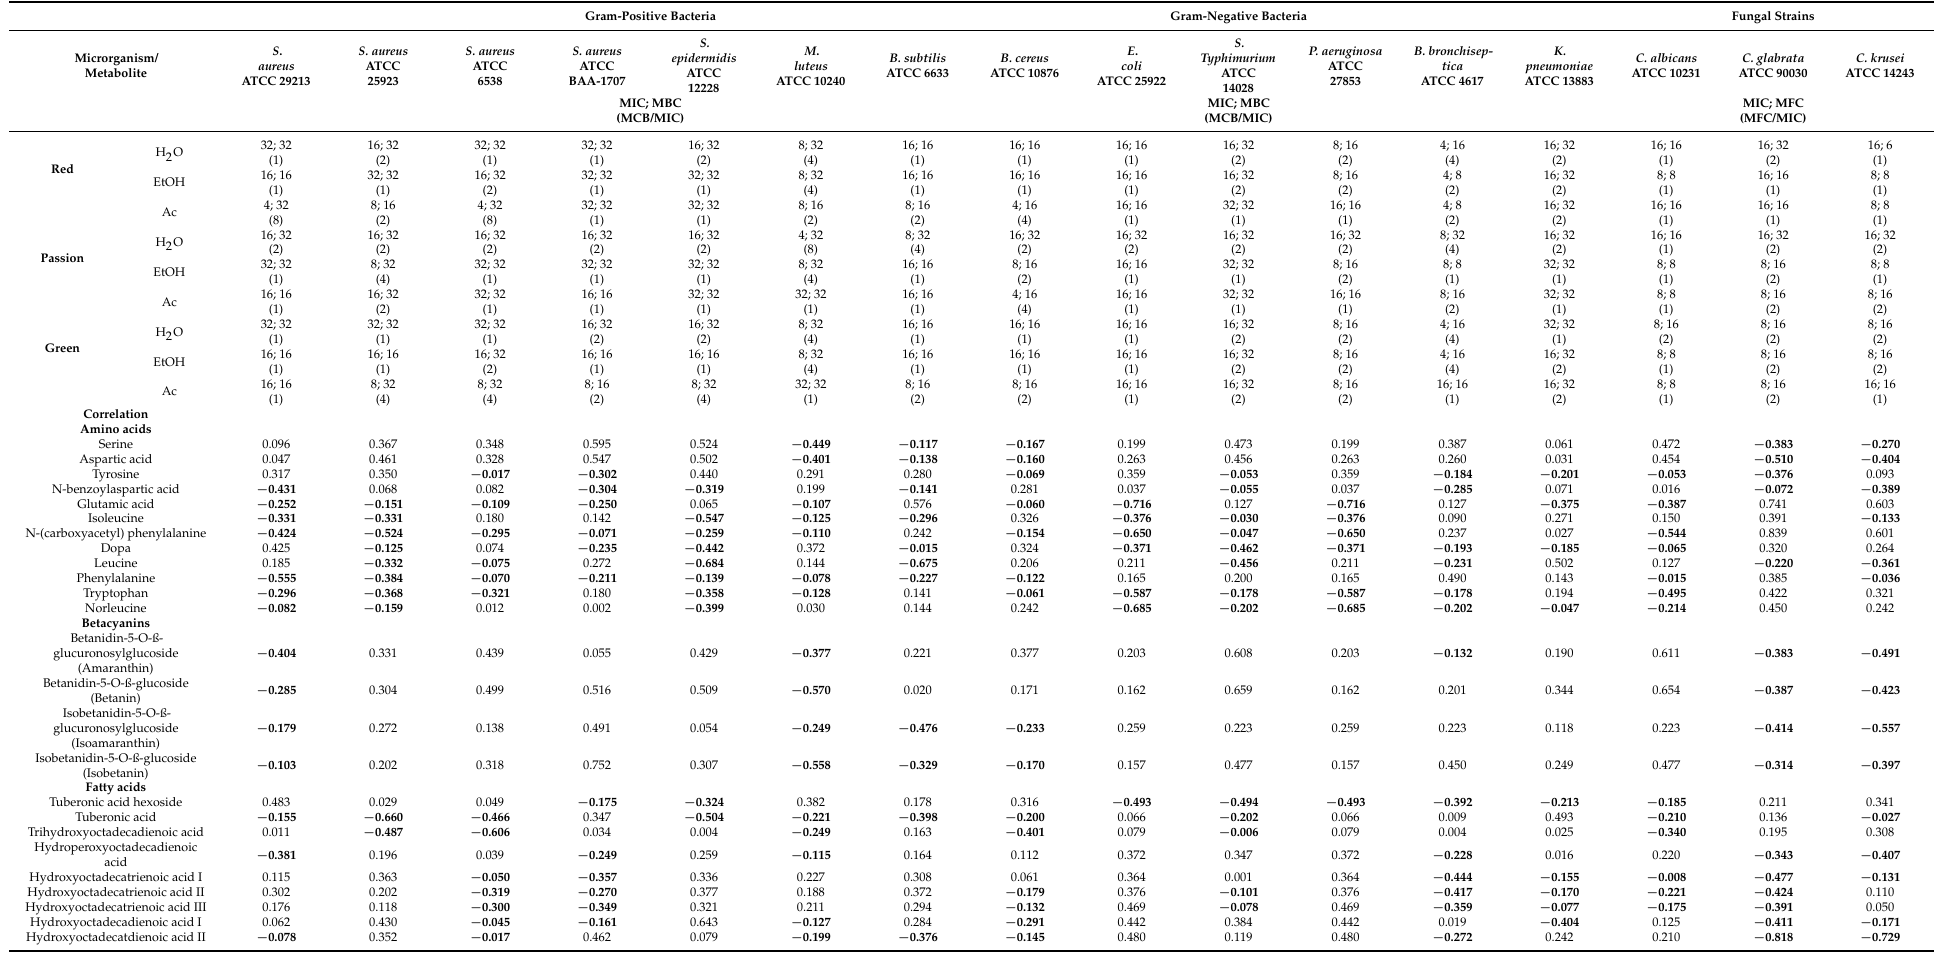
Table 3. Antimicrobial activity of three cultivars of A. tricolor Calaloo (Red, Passion and Green) assessed as the MIC (minimum inhibitory concentration),